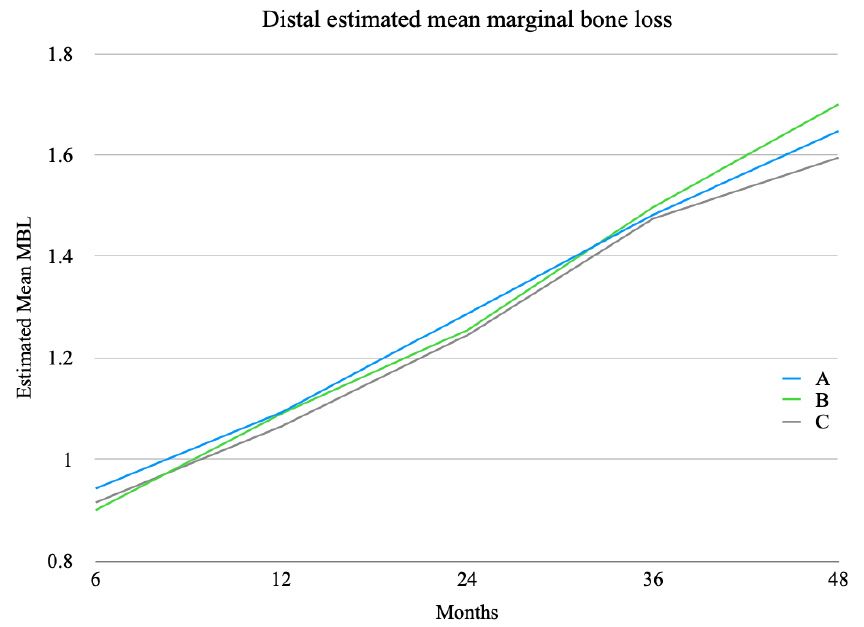
Figure 1. MBL for Implant 1, which tended to increase over the five time periods, irrespective of surgical approach.